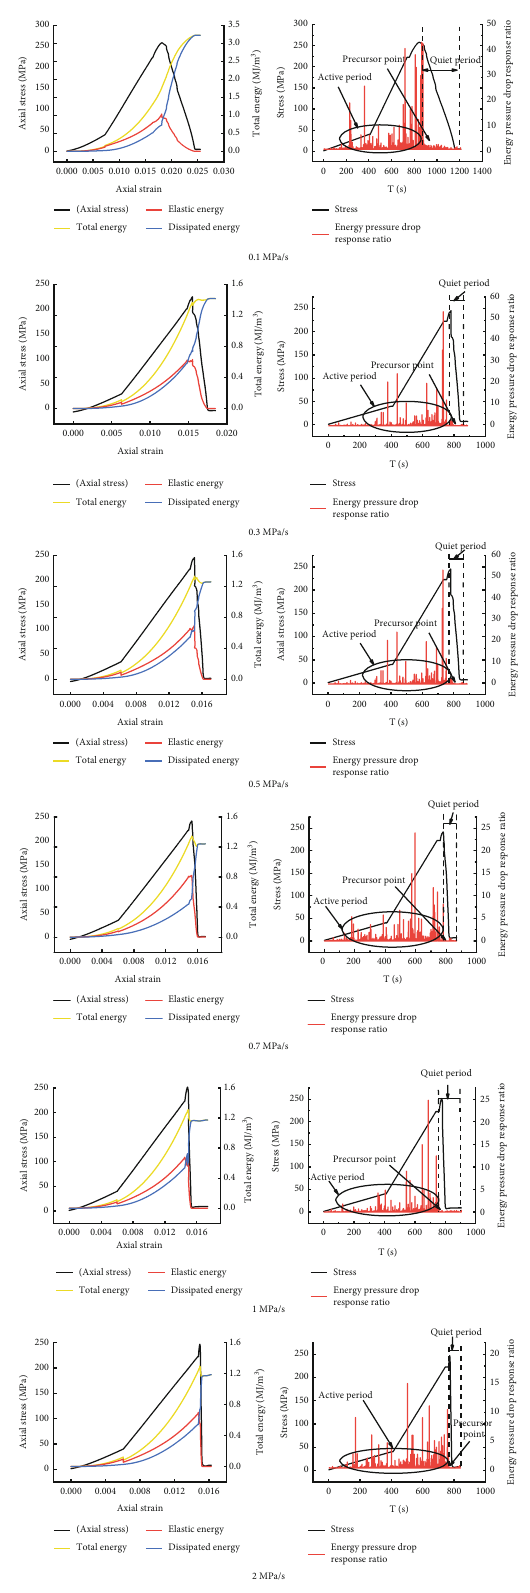
Figure 1: Limestone energy and energy pressure drop response ratio under di ff erent unloading rates at the same con fi ning pressure (40